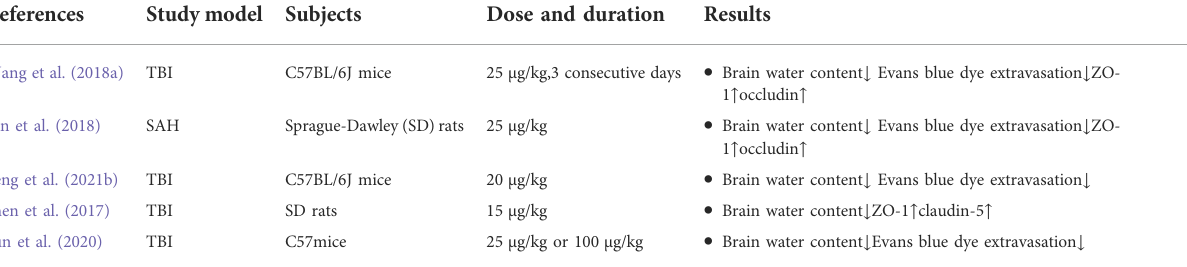
TABLE 4 Changes in brain water content and various tight junction